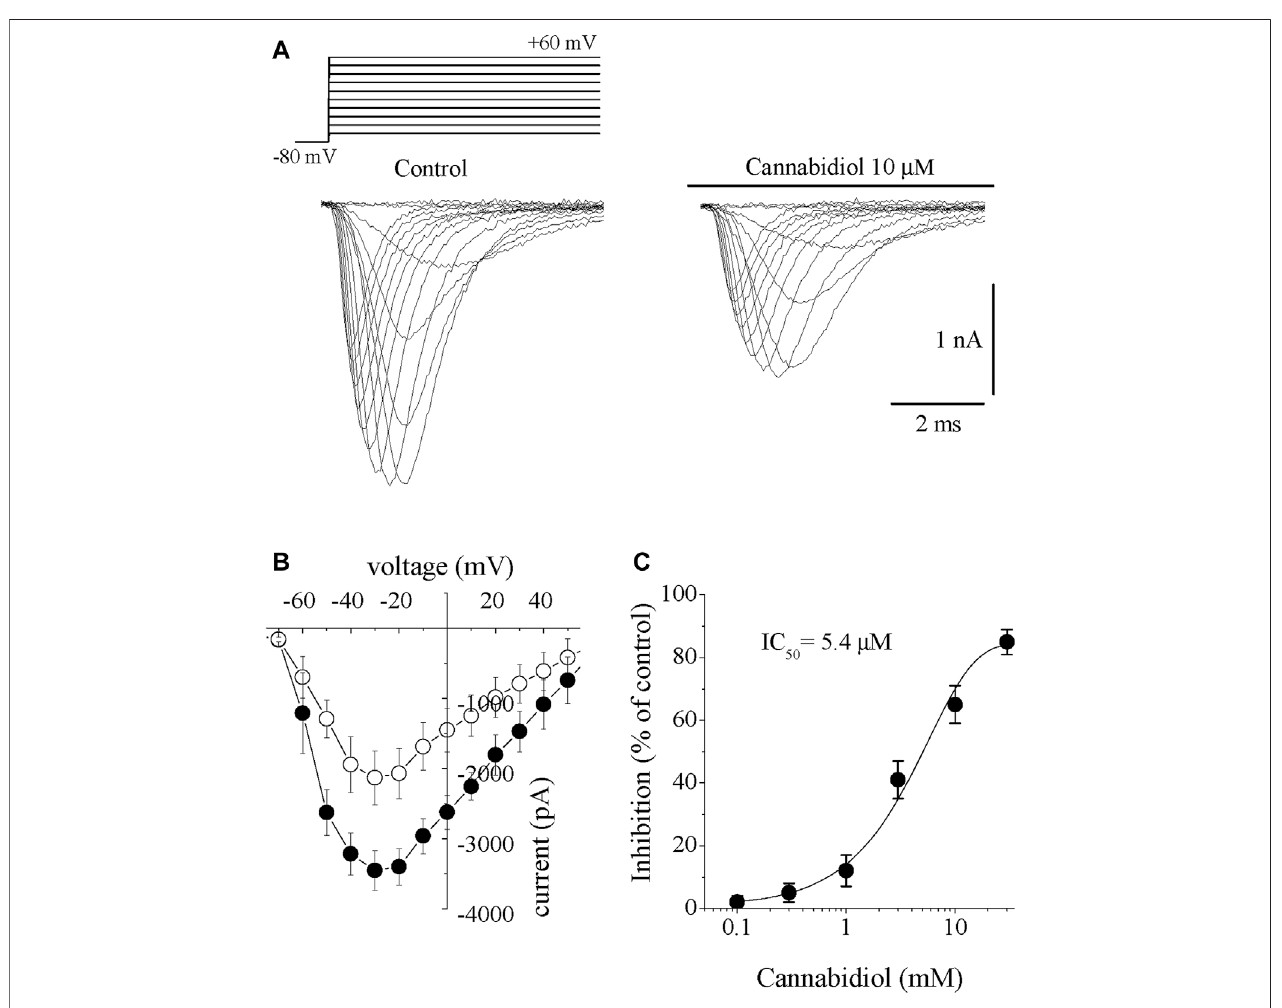
FIGURE1| Cannabidiolsuppressesthe I Na inrabbitventricularmyocytes (A) Originalcurrenttraceselicitedbyvoltagesintherangeof − 60 mVto+60 mVincontrol conditions (on the left) and 10 min after exposure to 10 μ M CBD (on the right). The pulse protocol to activate I Na is presented in the inset (B) Current-voltage relations of I Na in the absence and presence of 10 μ M CBD are presented with fi lled and open circles, respectively (n (cid:1) 6) (C) Concentration-inhibition curve for CBD suppression of I Na (n (cid:1) 6 –